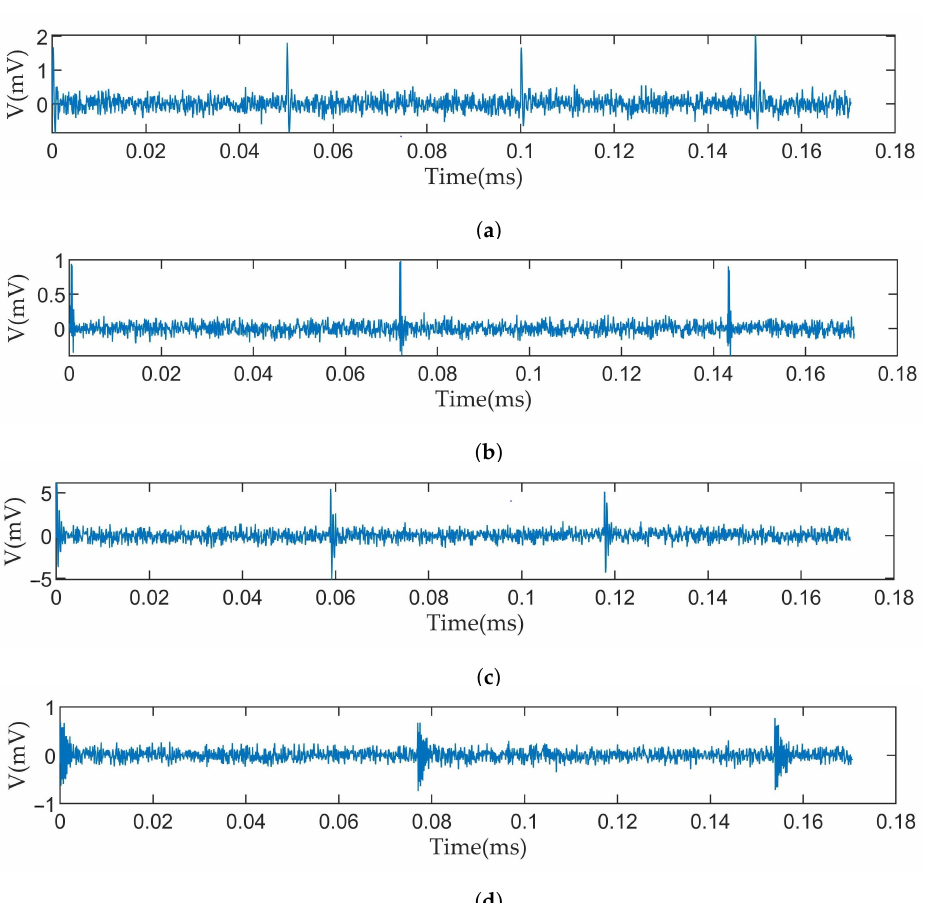
Figure 8. The simulated PD signals: ( a ) point discharge; ( b ) surface discharge; ( c ) air gap discharge; ( d ) suspended